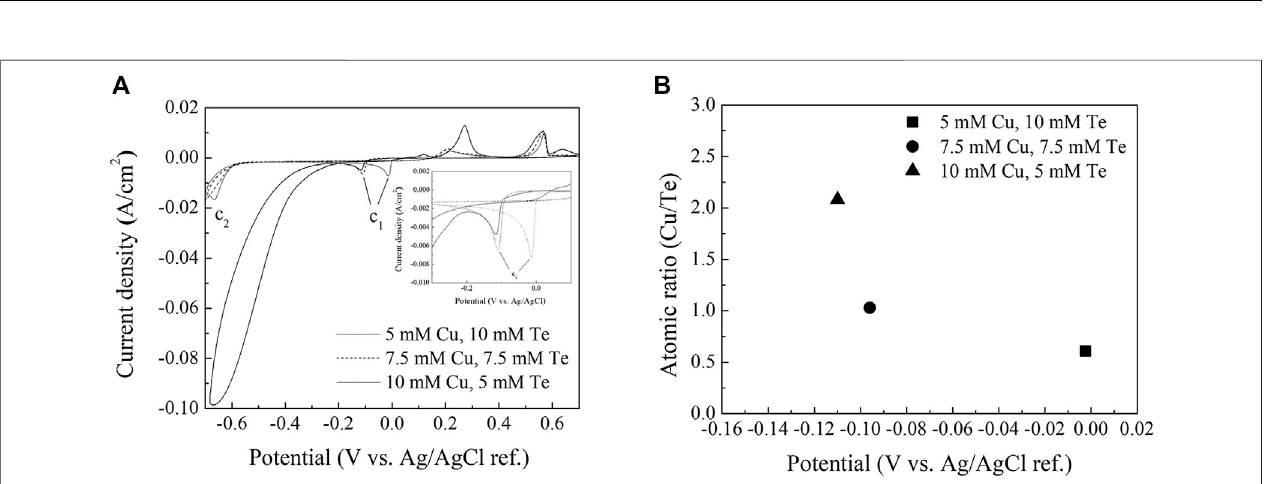
Frontiers in Chemistry |